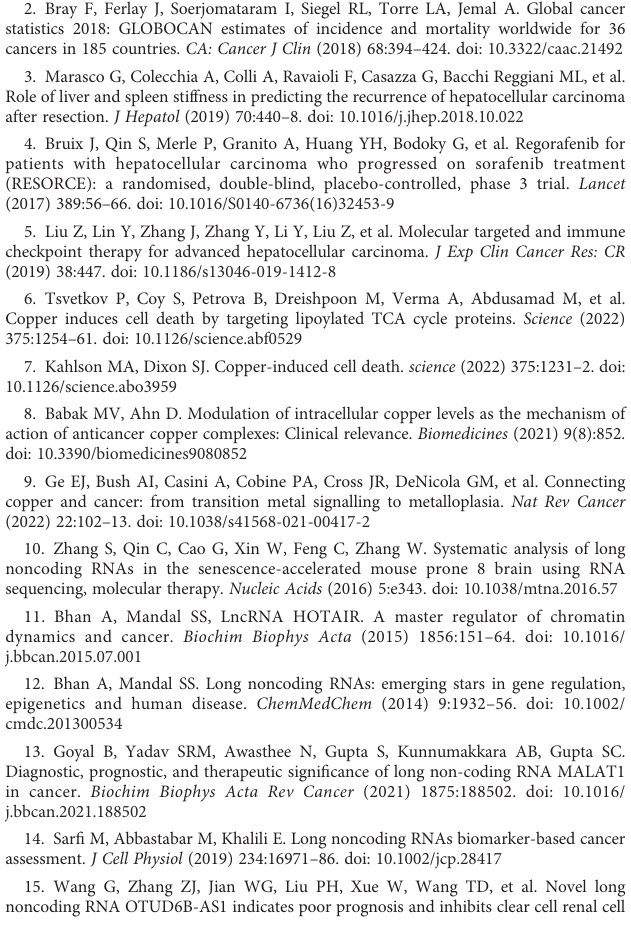
SUPPLEMENTARY FIGURE 1 Prognostic signature based on CLS in ICGC database. A. The AUC of CLS, age, gender and stage in ICGC database. B. The survival status and the expression of the 13 cuproptosis-related lncRNAs of each sample ranked from high to low CLSinICGCdatabase.C.Kaplan-Meier analysisofthehighandlowCLSpatients in ICGC database. D. The 1-, 3- and 5-year AUC of the CLS-based prognostic signature in ICGC. SUPPLEMENTARY FIGURE 2 The clinical application of CLS model in ICGC database. A. The estimated IC50 of 5- fl uorouracil, cisplatin, gemcitabine and doxorubicin in high and low CLS samples in ICGC. B. The IPS of each patients with high or low CLS in ICGC. C. TIDE analysis of the PD1 and CTLA4 response in patients with high and low CLS in ICGC. D. The proportion of the TIDE response in high and low CLS patients in ICGC. E. The AUC analysis of the CLS and biomarkers in ICGC. SUPPLEMENTARY FIGURE 3 MoA analysis in